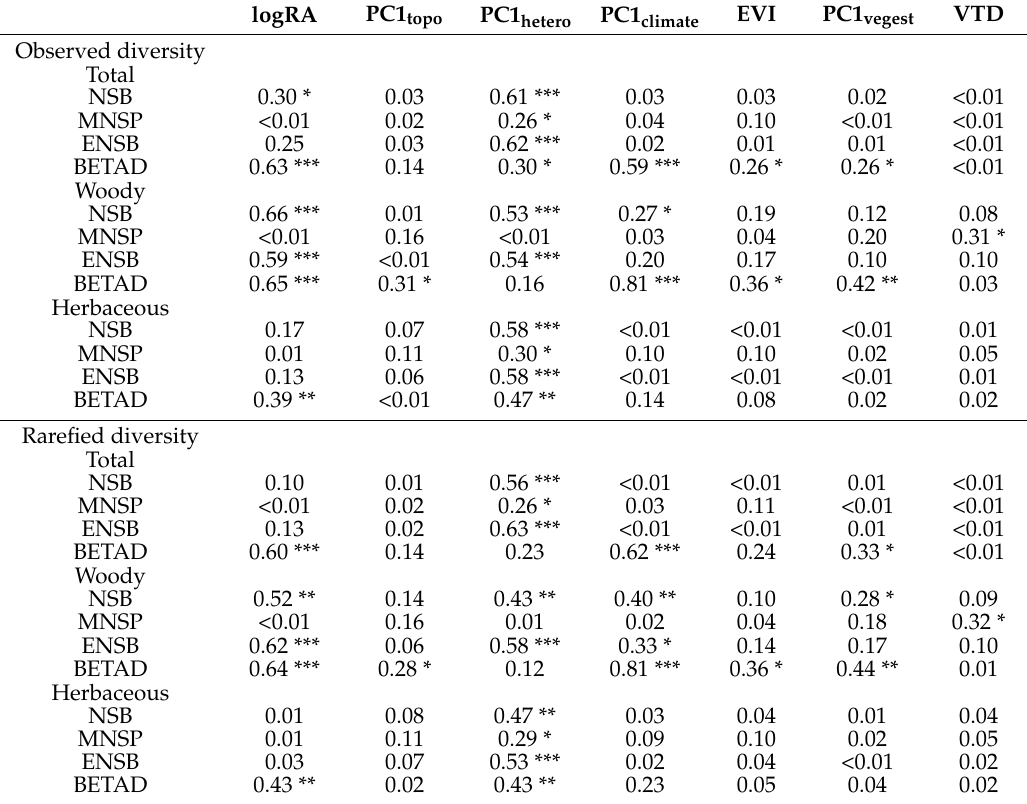
Table 3. Coefficients of determination ( R 2 ) and significance levels from simple linear regression models for explanatory variables and diversity indices of total, woody and herbaceous plants along the ridge of the Baekdudaegan Mountains, South Korea. Rarefied diversity was calculated with the same sample size ( n = 26) in each elevational band. PC1 topo